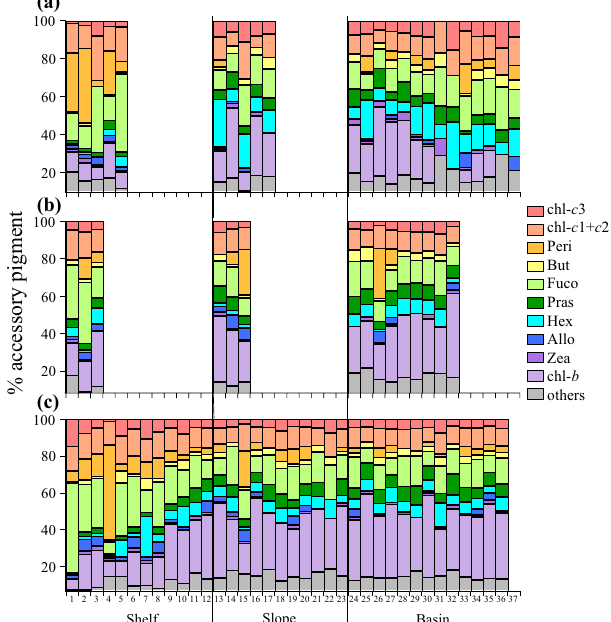
Fig. 1. Percentage contribution of major algal pigment detected by HPLC for all pigment sampled station in (a) 2008, (b) 2009 and (c) 2010. Data were sorted by station depths and divided into shelf ( ∼ 200m), slope (200–500m) and basin area ( ∼